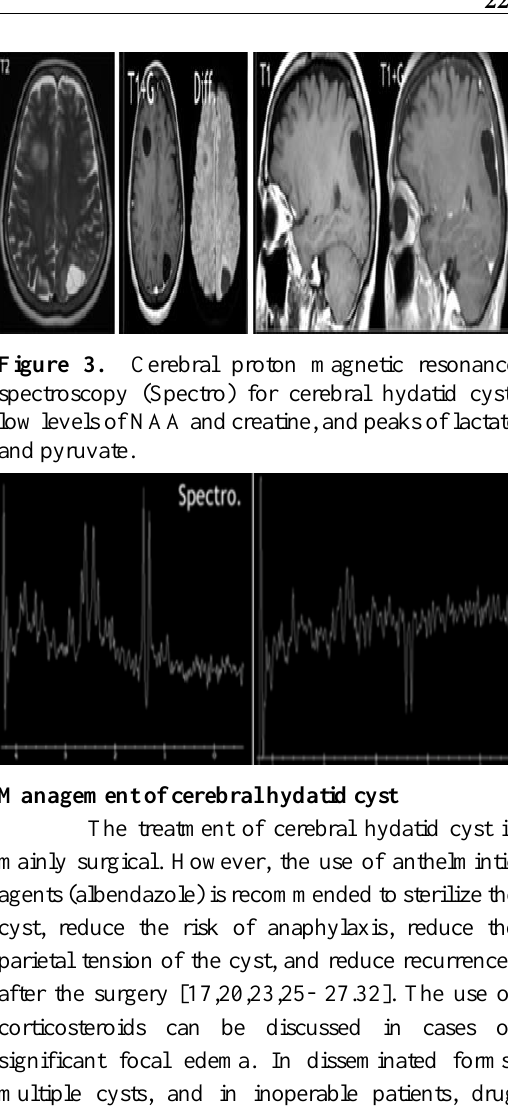
Figure 1. Axial cerebral CT: giant right parieto- occipital multivesicular hydatid cyst complicated with intracranial hypertension and a significant mass effect.